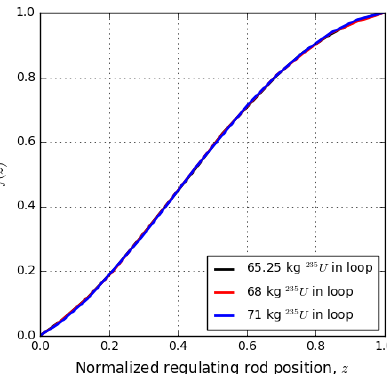
Figure 6. Regulating Curve of Regulating Control Rod in the Presence of (a) 65.25 kg 235 U in Loop, (b) 68 kg 235 U in Loop and (c) 71 kg 235 U in Loop.